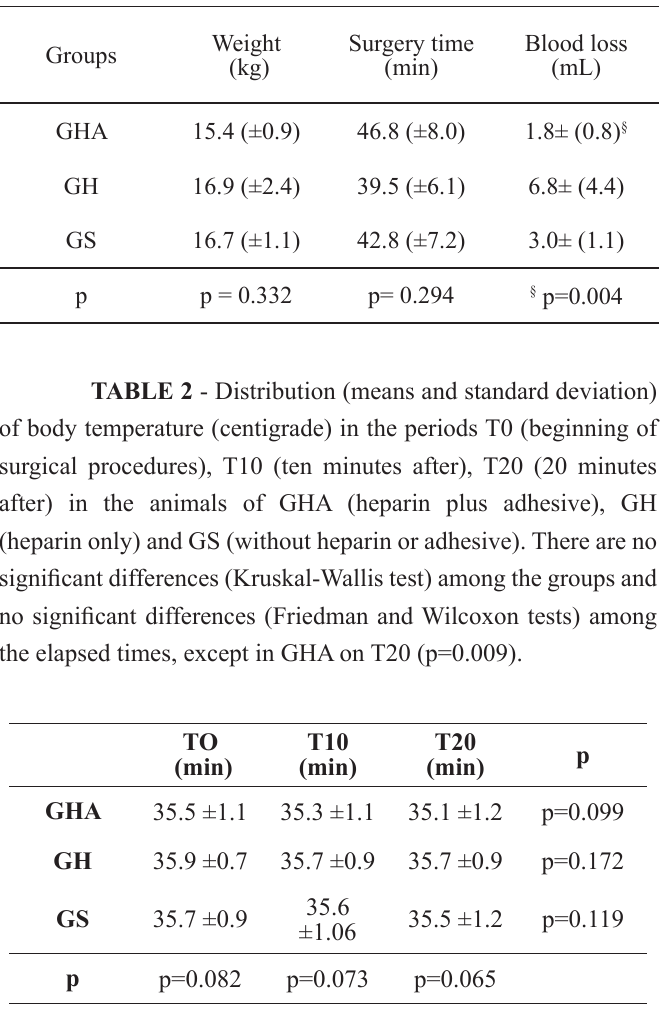
TABLE 3 - Distribution (means and standard deviation) of mean heart rate (beat/min) in the periods T0 (beginning of surgical procedures), T10 (ten minutes after), T20 (20 minutes after) in the animals of GHA (heparin plus adhesive), GH (heparin only) and GS (without heparin or adhesive). No significant